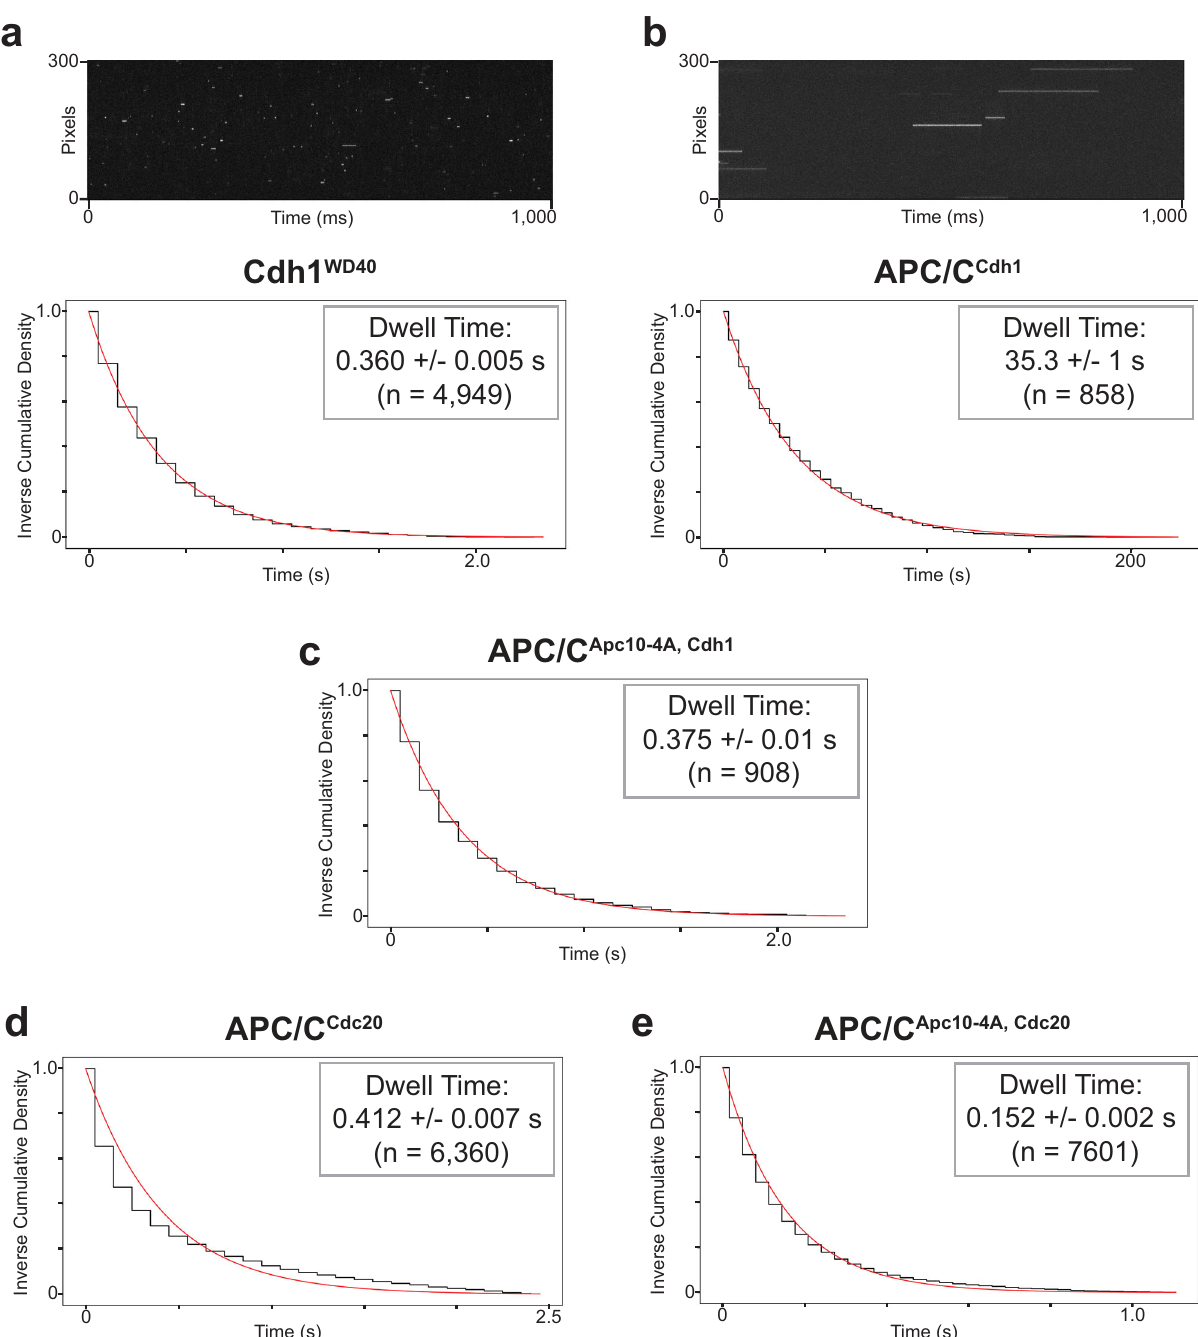
Fig. 4 Hsl1 D box binding analysis. Dwell time distributions from SMOR analysis of representative movies with Cy5-labeled Hsl1 D box peptide and GFP- tagged binding protein on the glass surface: a Cdh1 WD40 (100 pM peptide); b APC/C Cdh1 (100 pM peptide); c APC/C Cdh1 with Apc10-4A mutations (1 nM peptide); d APC/C Cdc20 (1 nM peptide); e APC/C Cdc20 with Apc10-4A mutations (1 nM peptide). Panels a and b include kymographs of binding events over time. Insets indicate mean dwell time ± SE ( n indicates number of selected peaks). Results are representative of two independent experiments (Supplementary Table